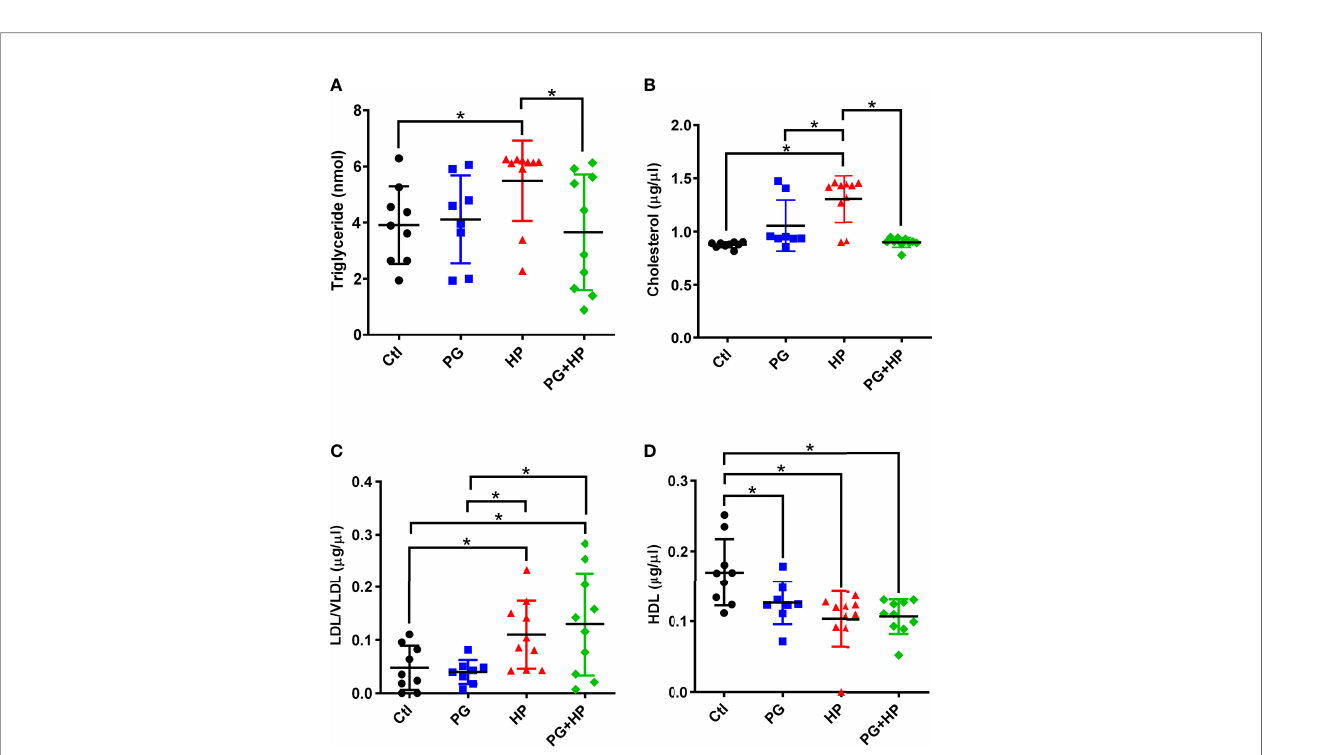
FIGURE 8 | P. goldsteinii MTS01 lowers serum triglyceride/cholesterol. Sera from mice were collected and the levels of (A) triglyceride, (B) total cholesterol, (C) LDL/VLDL, and (D) HDL were analyzed. * P <